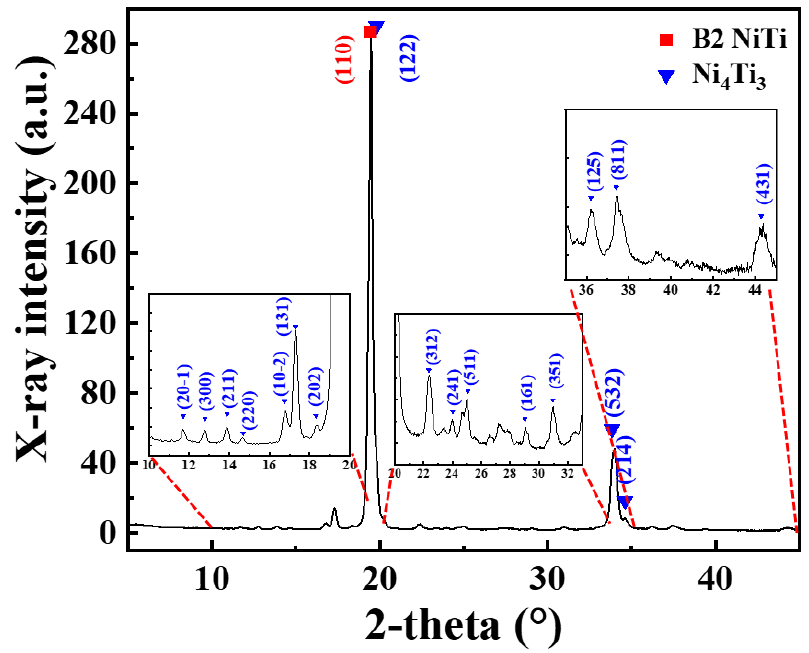
Figure 1. XRD pattern of the 60NiTi alloy.